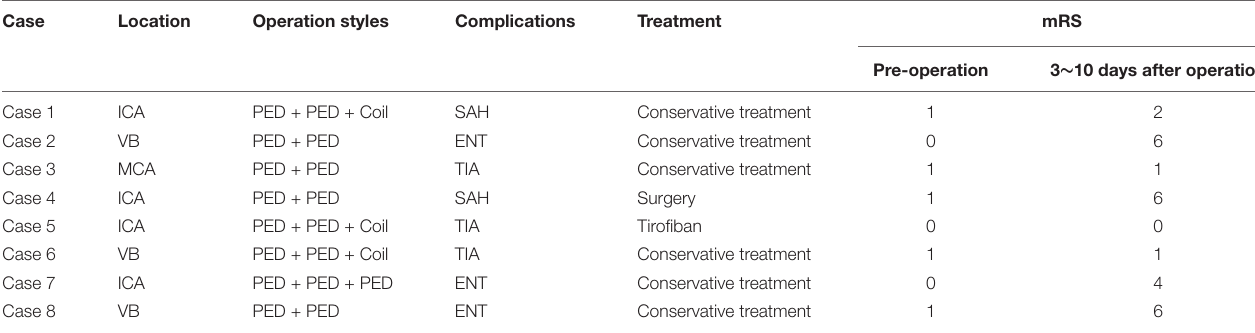
TABLE 3 | Perioperative